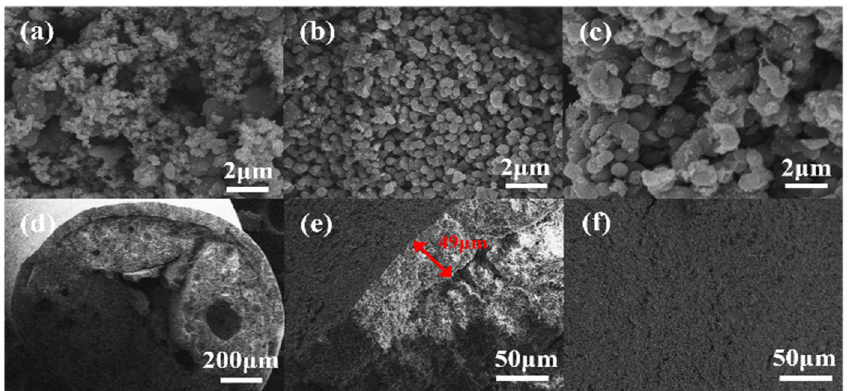
Figure 4. SEM images of N-TiO 2 prepared under different calcination temperatures and N-TiO 2 /SiC foam: ( a ) N-TiO 2 -300, ( b ) N-TiO 2 -400, ( c ) N-TiO 2 -500, ( d , e ) cross-section, and ( f ) outer surface.